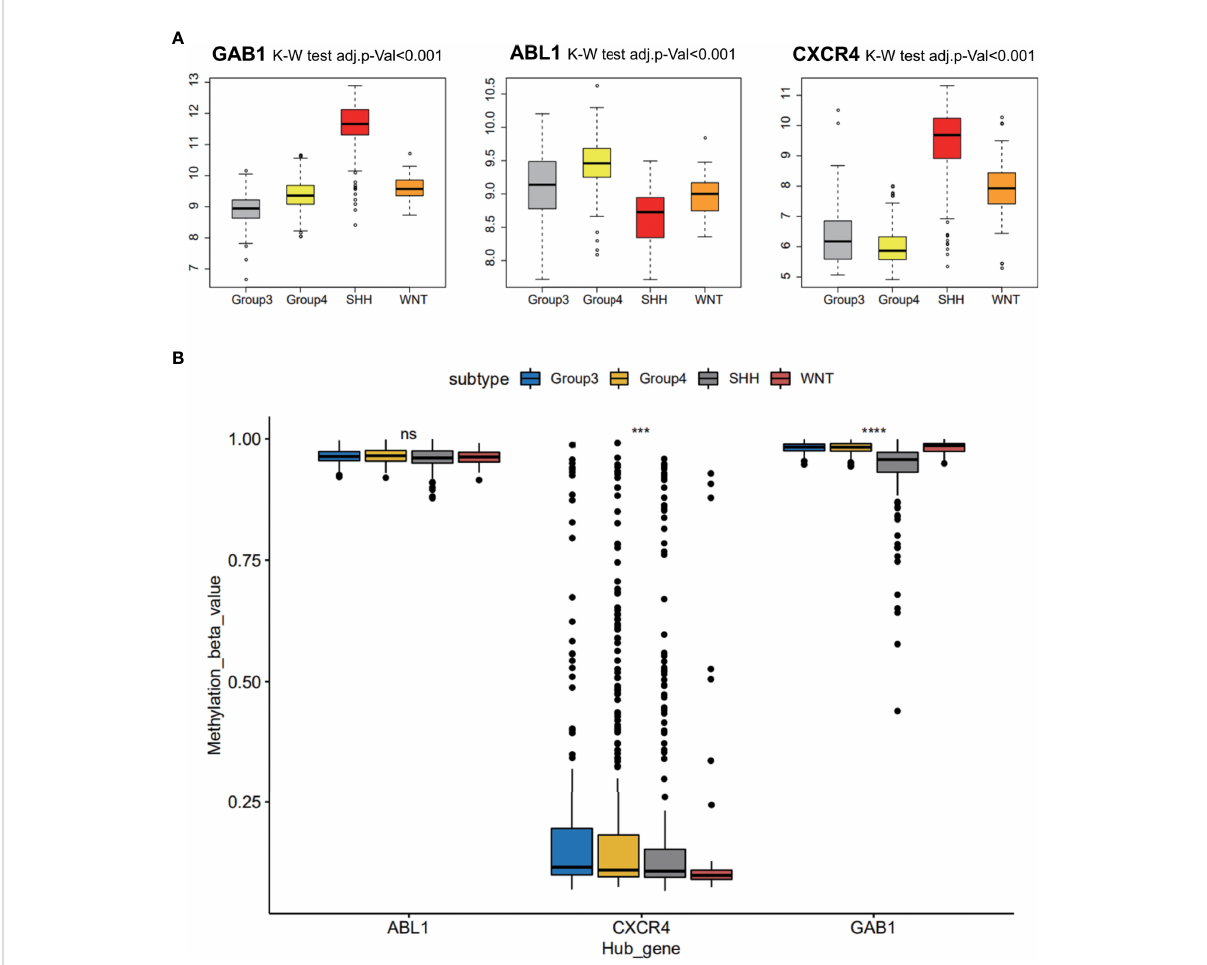
FIGURE 5 Medulloblastoma subgroup marker recognition based on hub genes. (A) Three hub gene expression patterns in the subgroups of medulloblastoma. (B) The methylation level of immune hub genes among the four subgroups was established by combining the immune hub gene with the DNA methylated data. ns, p > 0.05; *** p ≤ 0.001; **** p ≤